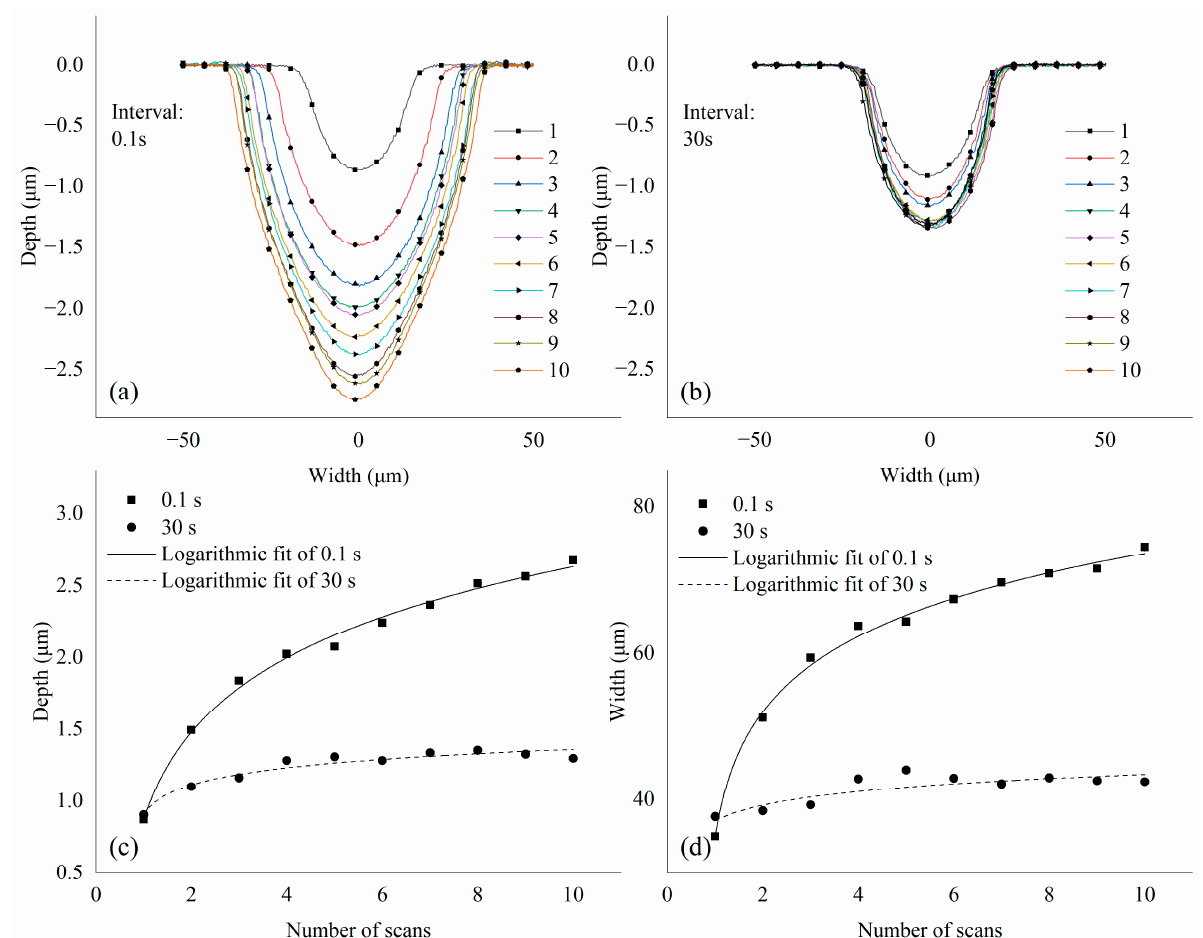
Figure 2. The evolution of HF-acid etched section profiles on fused silica with increasing repeat scans for the scanning time intervals of 0.1 s ( a ) and 30 s ( b ), respectively. HF-acid etched depth ( c ) and width ( d ) with the increasing number of scans on fused silica.